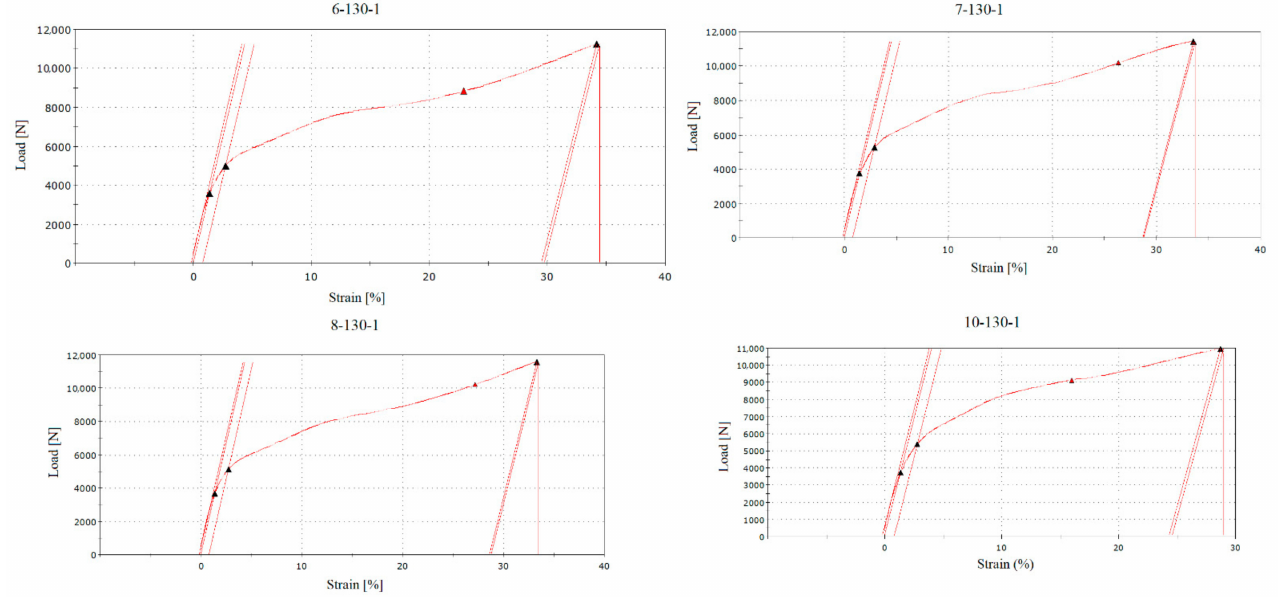
Figure 13. Comparison of samples “6-130-1”, “7-130-1”, “8-130-1”, and “10-130-1” via a tensile diagram with a marked point (red triangle) of RFID tag damage and its